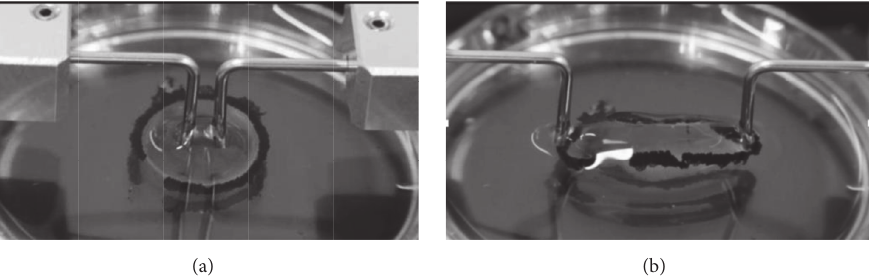
Figure 2: Images of the capsule stretch experiment. Two L-shaped jigs are inserted into the capsule opening (a); one side is pulled at constant speed (b).